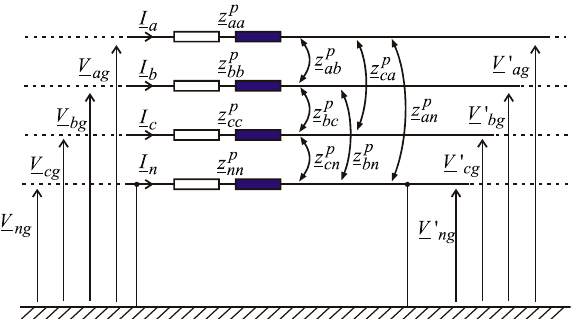
Figure 4. Unit length segment of a three-phase OHL and its self and mutual primitive impedances.